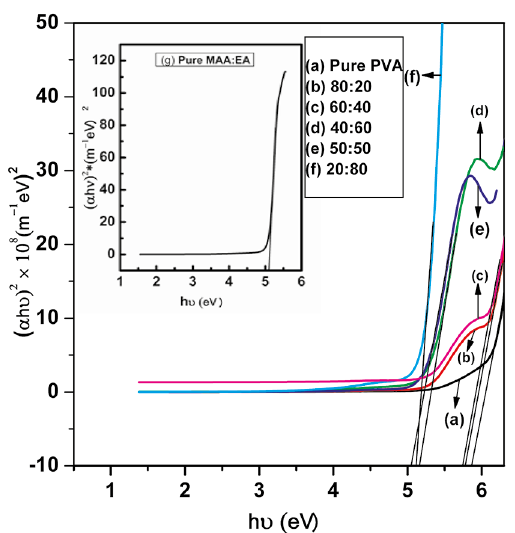
Figure 10. (αhυ) 2 vs hυ curves of pure and PVA/MAA:EA blend samples (a) Pure PVA (b) 80:20 (c) 60:40 (d) 40:60 (e) 50:50 (f) 20:80 (g) Pure MAA:EA Table 4. Values of absorption edge and optical band gap of pure and PVA/MAA:EA blend samples. PVA/